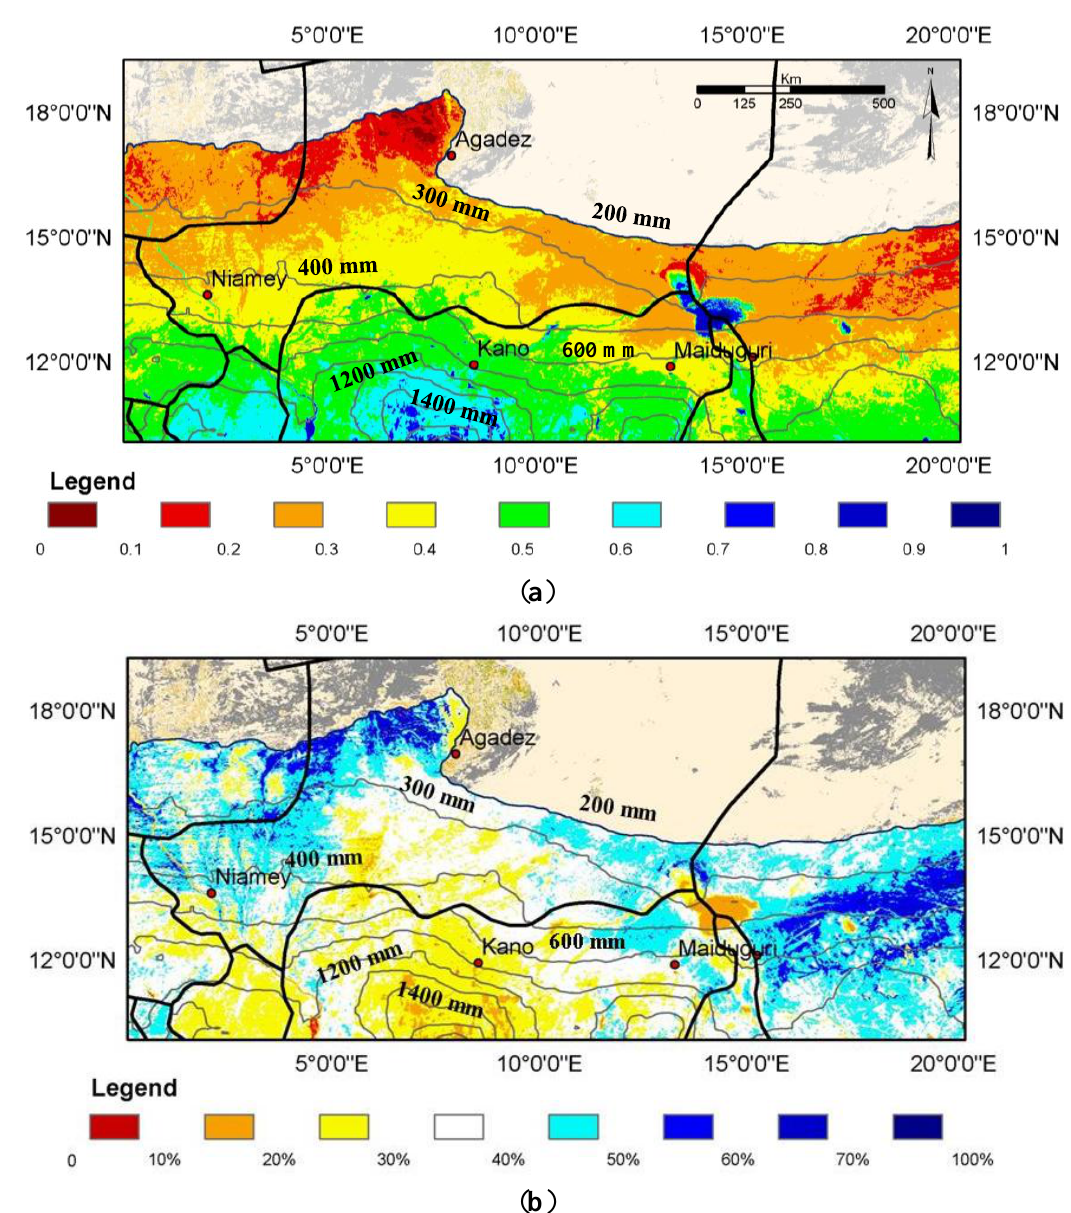
Figure 5. The map of the average EF ( a ) and relative standard deviation ( b ) derived from 448 EF eight-day maps (2000–2009). Isohyets were calculated from rainfall estimation (RFE) data for the same period. The hyper-arid areas (<200 mm∙year −1 ) are masked out, and the GlobCover map is in the